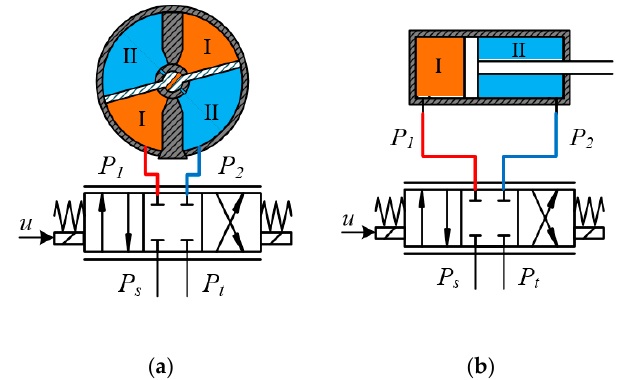
Figure 2. Working principle of electro-hydraulic actuators: ( a ) rotary type, ( b ) cylinder type.